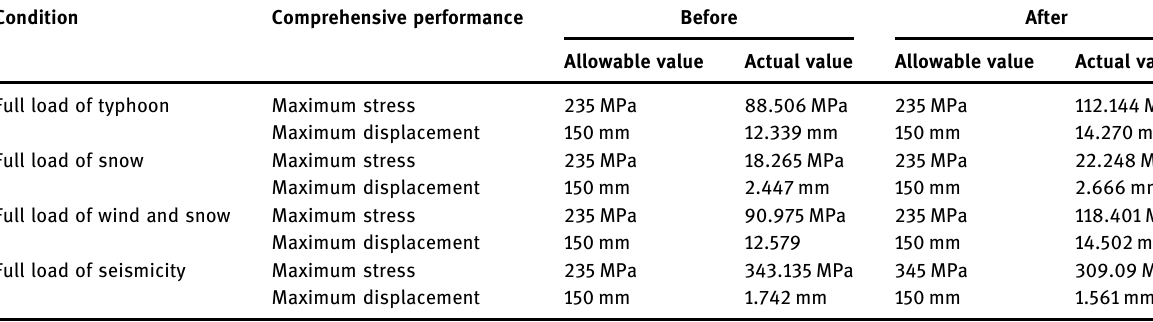
Table 11: Before and after comparison of the comprehensive performance